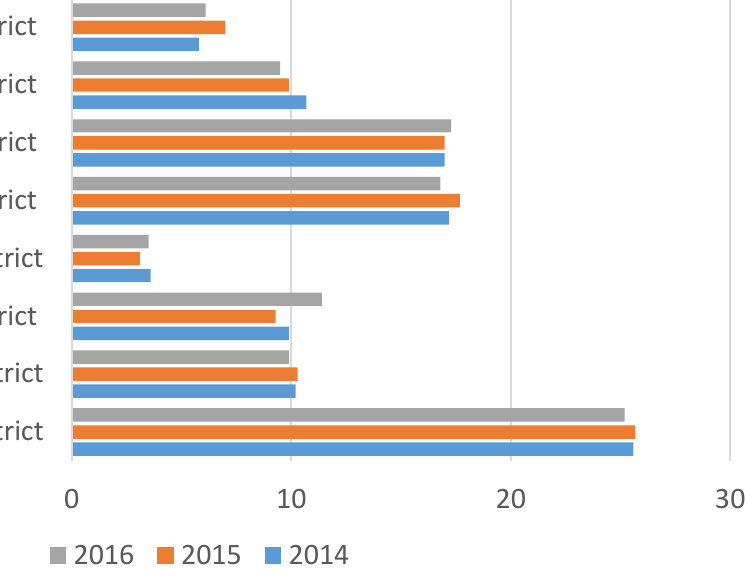
Figure 3. Investments in the fixed capital of enterprises